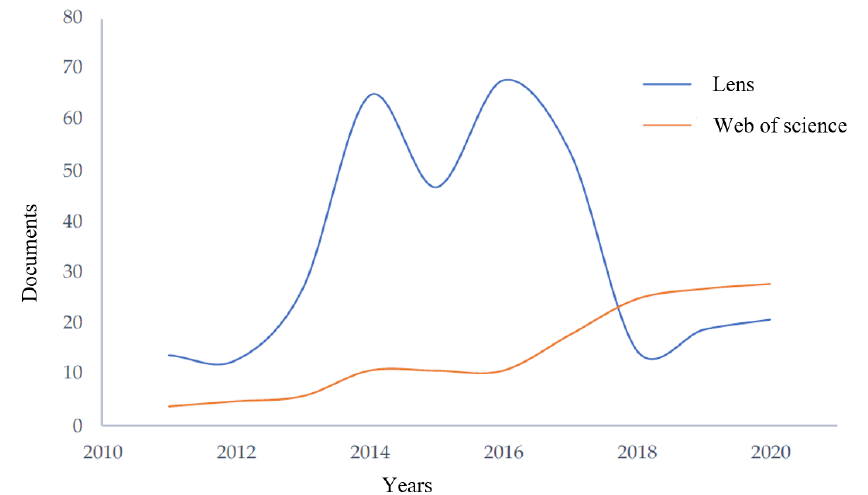
Figure 3. Annual production of articles found by two databases.